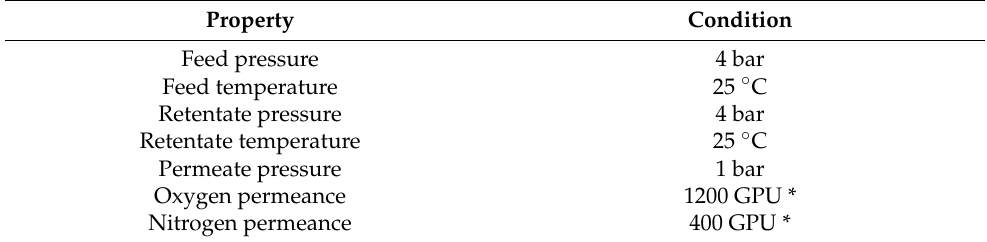
Table 4. Operating conditions of the membrane unit for oxygen